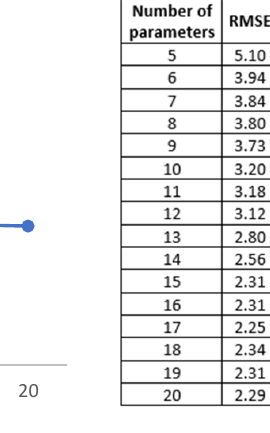
Figure 9. Root mean squared error of cross validation (RMSECV) as a function of number of parameters used in the L foliage model.